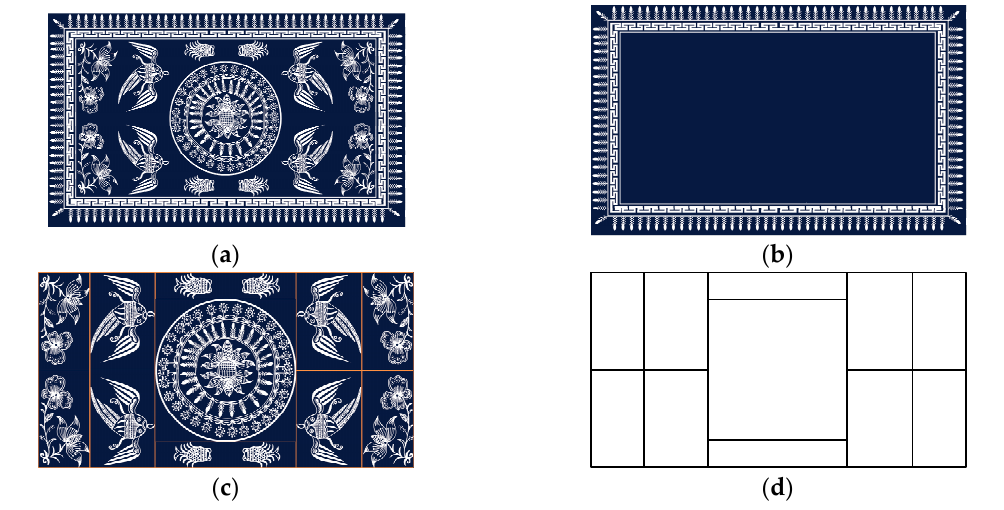
Figure 3. Representation of the composition of a batik shape pattern. ( a ) Batik shape tablecloth, ( b ) border pattern of a batik shape tablecloth, ( c ) main pattern of a batik shape tablecloth, and ( d ) pattern structure of a batik shape tablecloth.